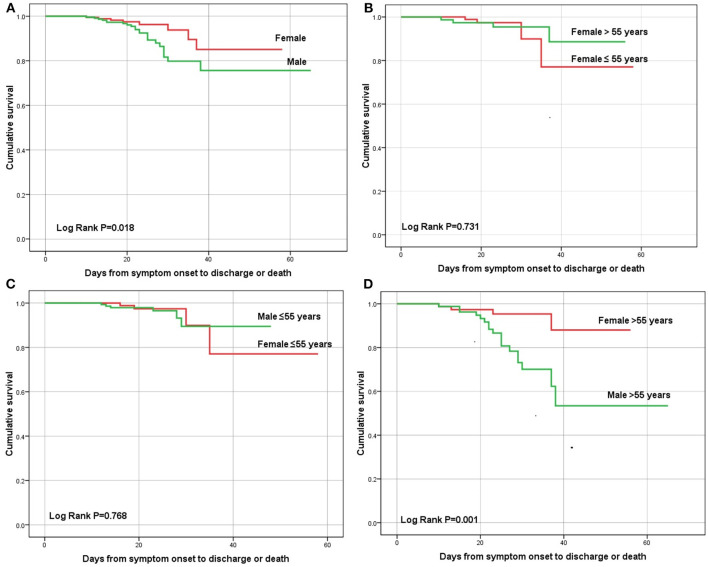
Kalpan-Meier survival curve of male and female patients with COVID-19 in (A) male vs. female, (B) age ≤ 55 years vs. age > 55 years in female patients, (C) male vs. female in age ≤ 55 years old group, and (D) male vs. female in age > 55 years old group by log-rank test for all.